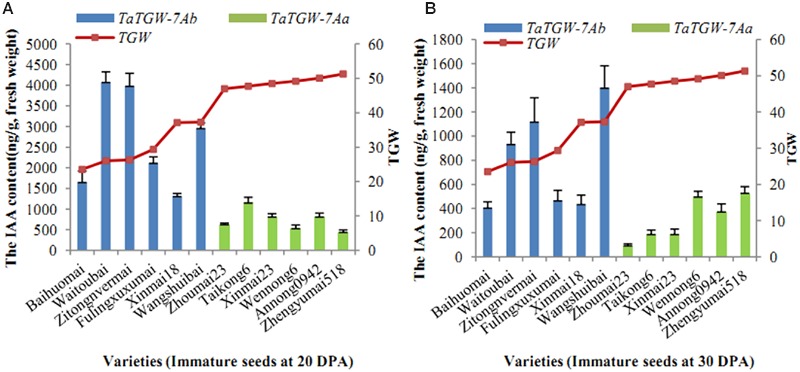
Relationship between IAA content of TaTGW-7A genotype and TGW. (A,B) means the two stages of 20 DPA and 30 DPA.